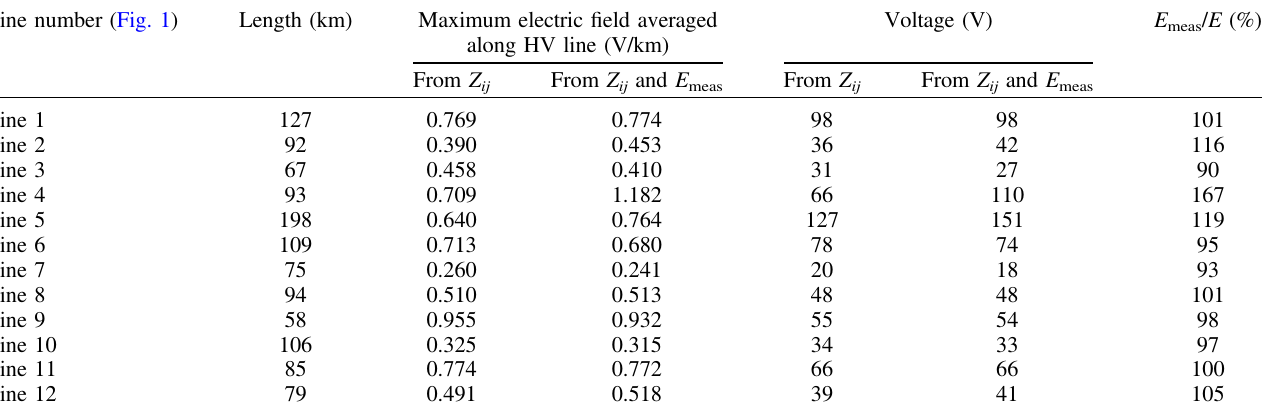
Table 2. Maximum peak-to-peak electric fi elds for the September 2017 magnetic storm averaged (see Methods Sect. 2.2) in directions delineated by the 12 high-voltage (HV) transmission lines shown in Figure 1 and their associated transmission-line voltages. E meas are the measured electric fi elds (Simpson & Bahr, 2020a, 2020b) from sites ACH, ELC, CAI, TAN, MAR, LEA and RAN. E meas / E percentages are the magnitudes of quantities estimated with E meas substituted from the aforementioned 7 sites relative to those estimated using Z ij . Line number (Fig. 1)